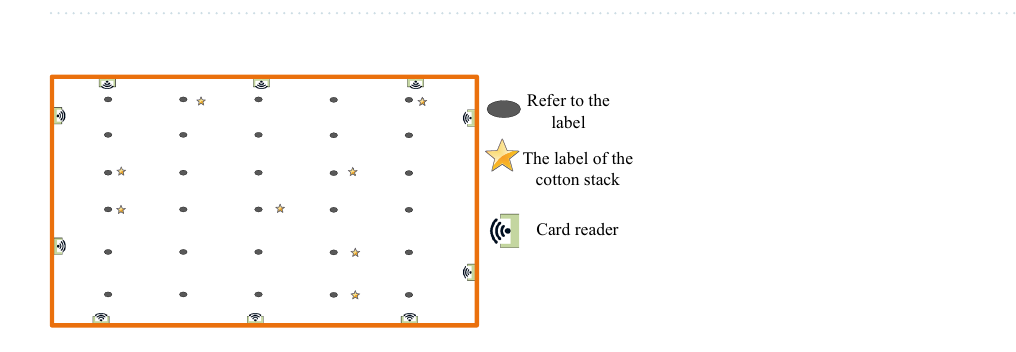
Figure 13. Software system flow chart. ( a ) Hand-held inspection terminal system software system design flowchart ( b ) RFID assisted manual inspection path planning process.